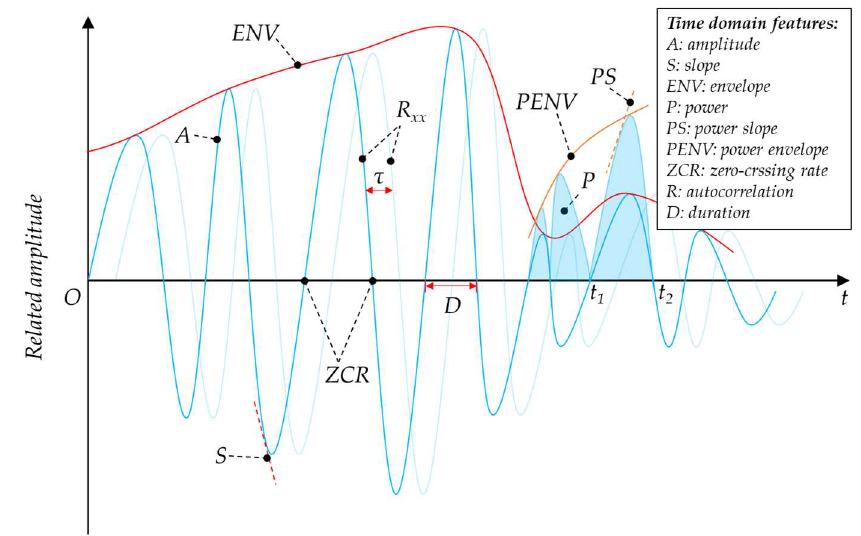
Figure 5. Time domain features.